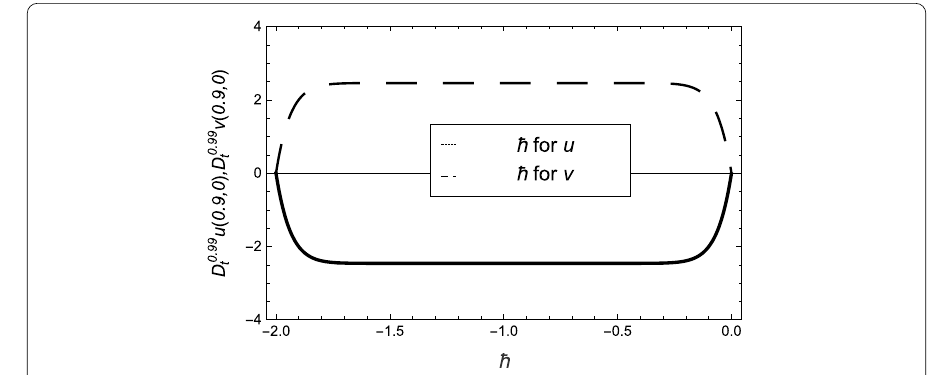
Figure 1 (cid:2) -curve using 15 terms of approximation for Example